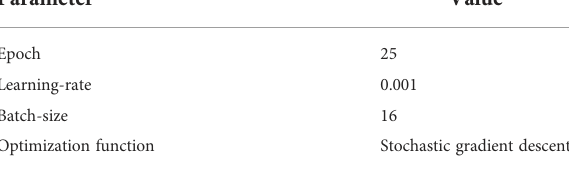
TABLE 3 Model training